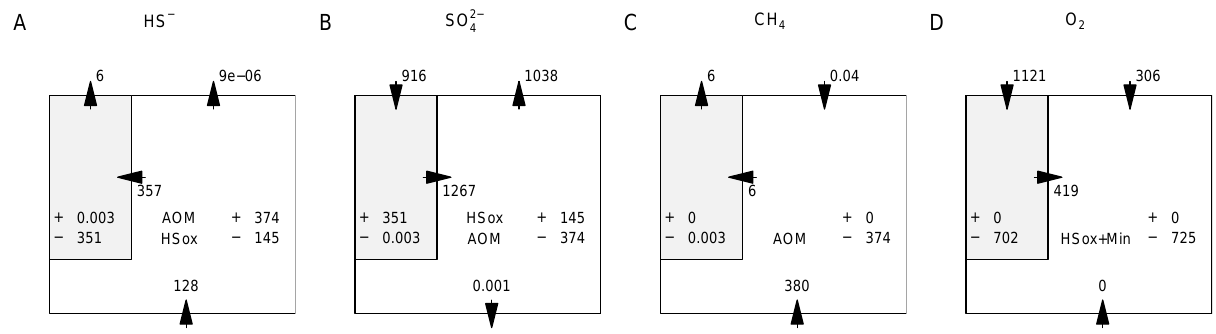
Fig. 4. Budgets of HS − , SO 2 − , CH 4 , and O 2 in nmolcm − 2 d − 1 ; the grey area is the worm; the upper interface is the sediment–water 4 interface.